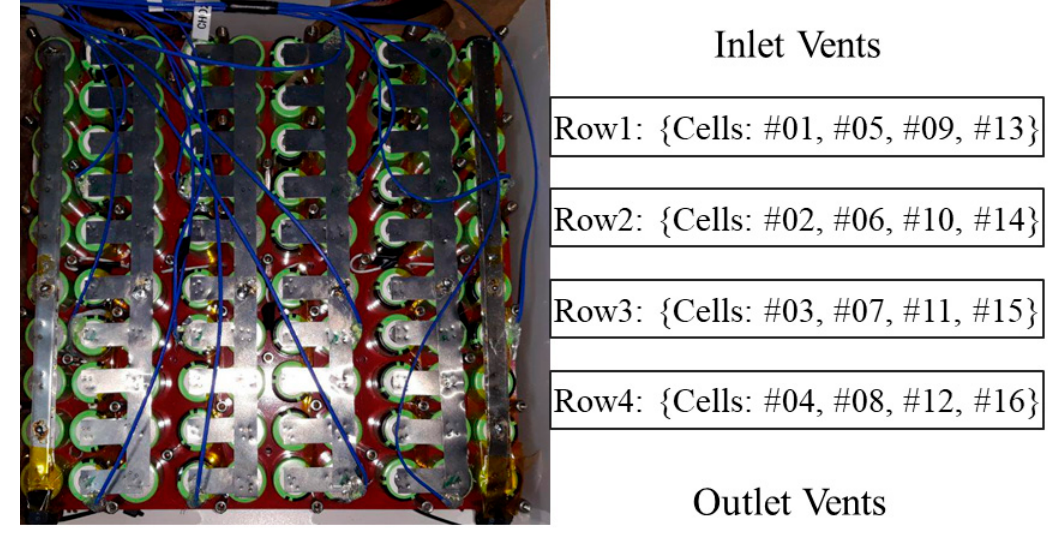
Figure 14. Sensor position nomenclature.